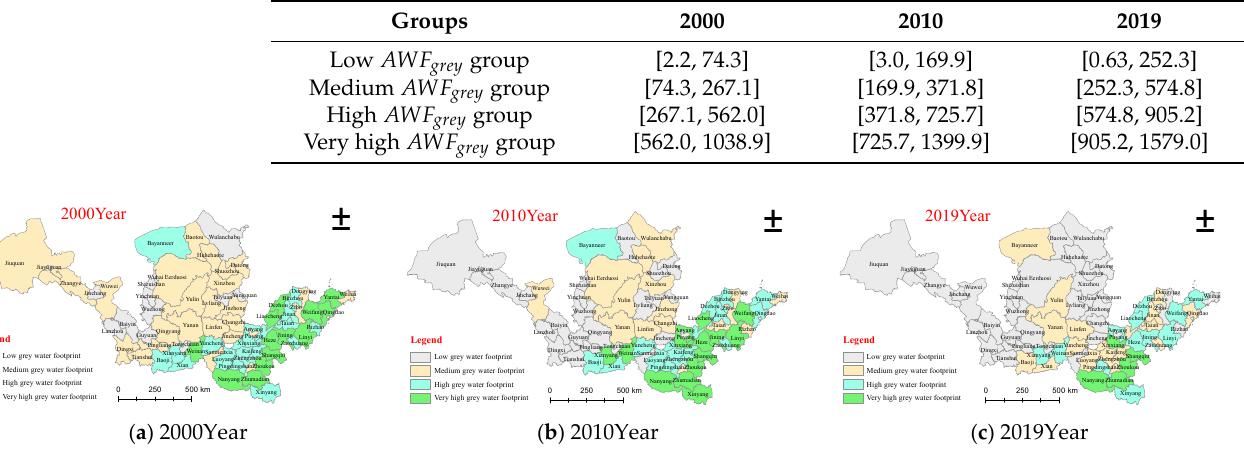
Figure 5. Moran’s index diagram of global autocorrelation of the 𝐴𝑊𝐹 (cid:3034)(cid:3045)(cid:3032)(cid:3052) of prefecture-level cities in the Yellow River Basin. As the global Moran’s I index is an overall autocorrelation statistic, which represents whether the elements are distributed with significant aggregation or separation at the overall level, it cannot reveal the spatial agglomeration degree of specific regions. The LISA agglomeration map is a clearer visual expression of the local Moran’s I scatter plot. Analyzing the LISA agglomeration map can help to identify the “hot spot” and “blind spot” areas of the 𝐴𝑊𝐹 (cid:3034)(cid:3045)(cid:3032)(cid:3052) in the Yellow River Basin and intuitively represent the local characteristics of the 𝐴𝑊𝐹 (cid:3034)(cid:3045)(cid:3032)(cid:3052) in spatial distribution. Therefore, in this study, typical years were selected and LISA clustering maps were drawn for the 𝐴𝑊𝐹 (cid:3034)(cid:3045)(cid:3032)(cid:3052) for each pre- fecture-level city in the Yellow River Basin in 2000, 2010, and 2019 (Figure 6).